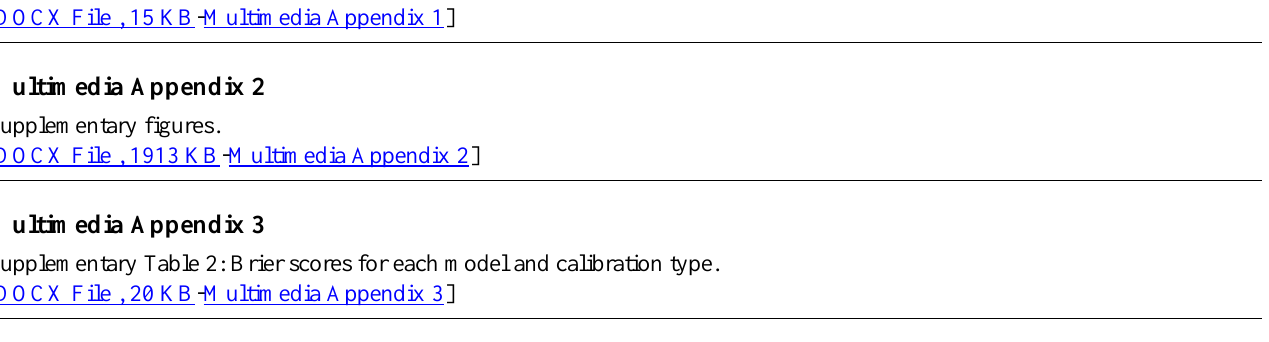
Supplementary Table 3: TRIPOD guidelines.